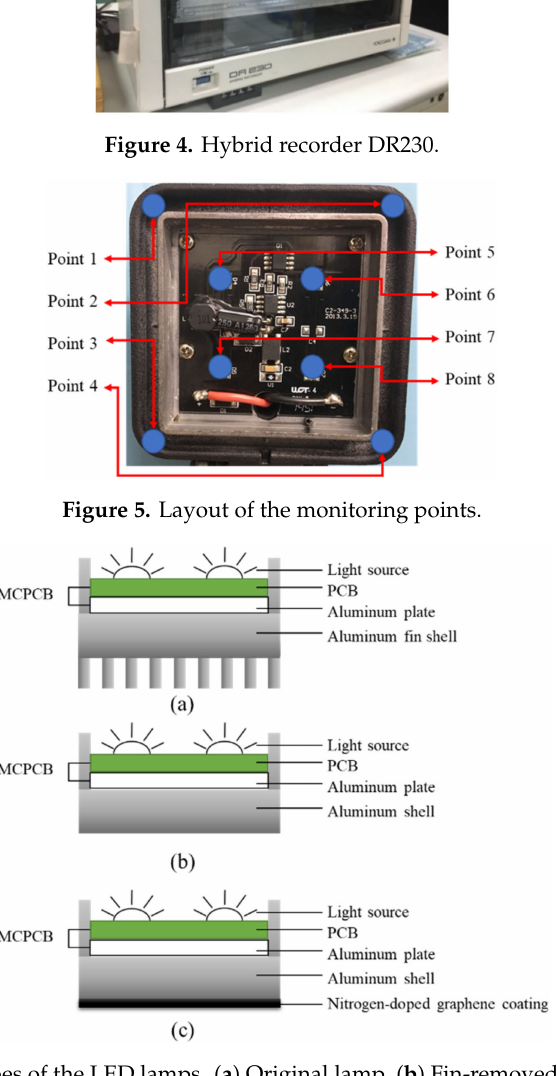
Figure 6. Di ff erent types of the LED lamps. ( a ) Original lamp, ( b ) Fin-removed lamp, ( c ) NGC